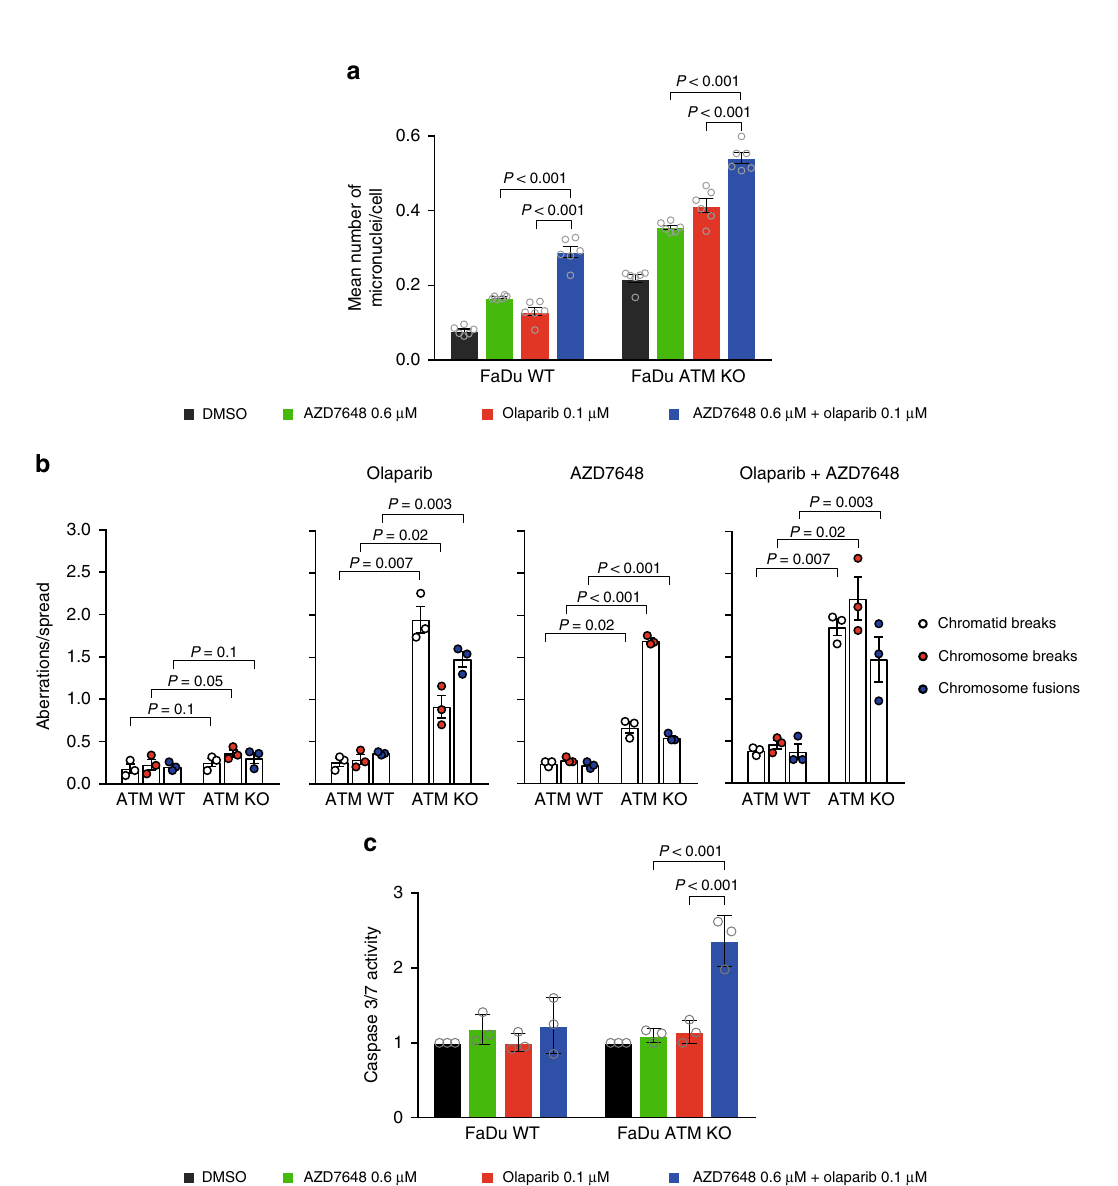
Fig. 7 AZD7648 in combination with olaparib affects genome stability and induces apoptosis in ATM KO cells. a Frequency of micronuclei formation in FaDu WT and ATM KO cells following 72 h treatment. Data are shown as mean number of micronuclei per cell (mean ± SEM; n = 2; unpaired t -test, P ≤ 0.05 is signi fi cant). b Chromosomal aberrations in FaDu WT and ATM KO cells treated with olaparib (1 μ M), AZD7648 (1 μ M), or the combination for 48